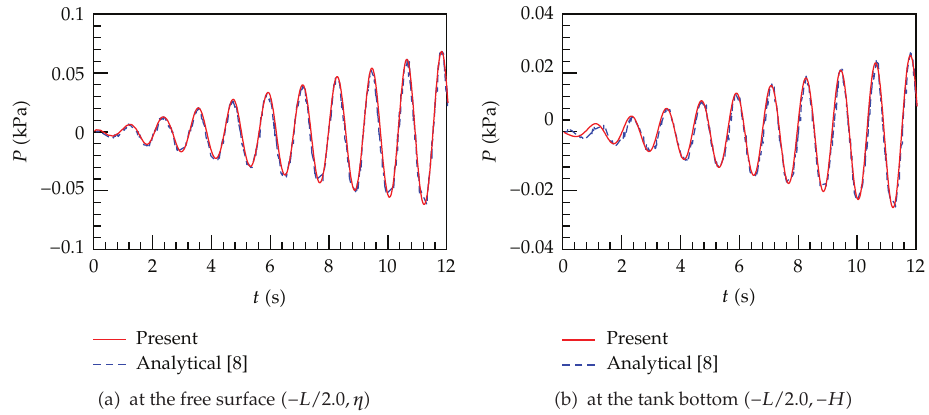
Figure 7: Time histories of hydrodynamic pressure at the free surface and tank bottom of the left tank